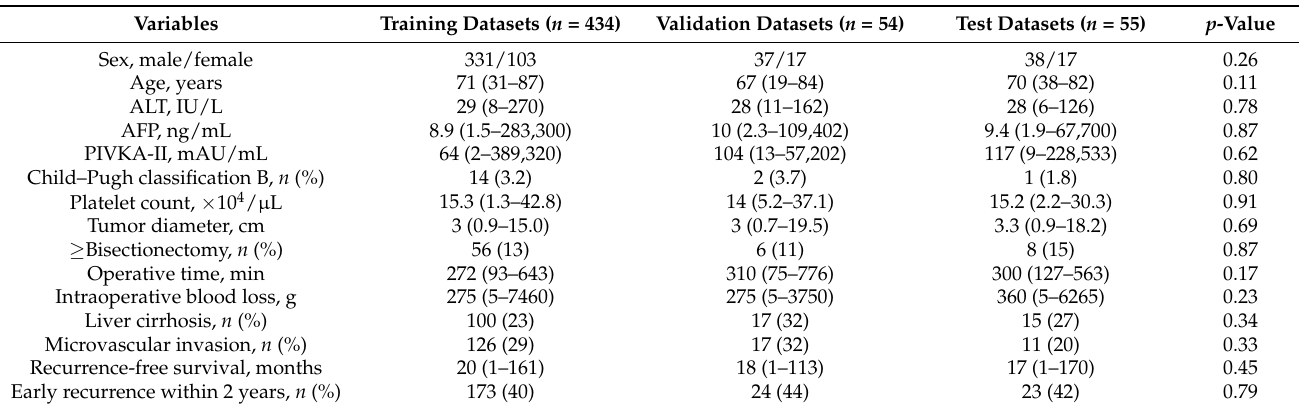
Table 2. Patient’s characteristics in each